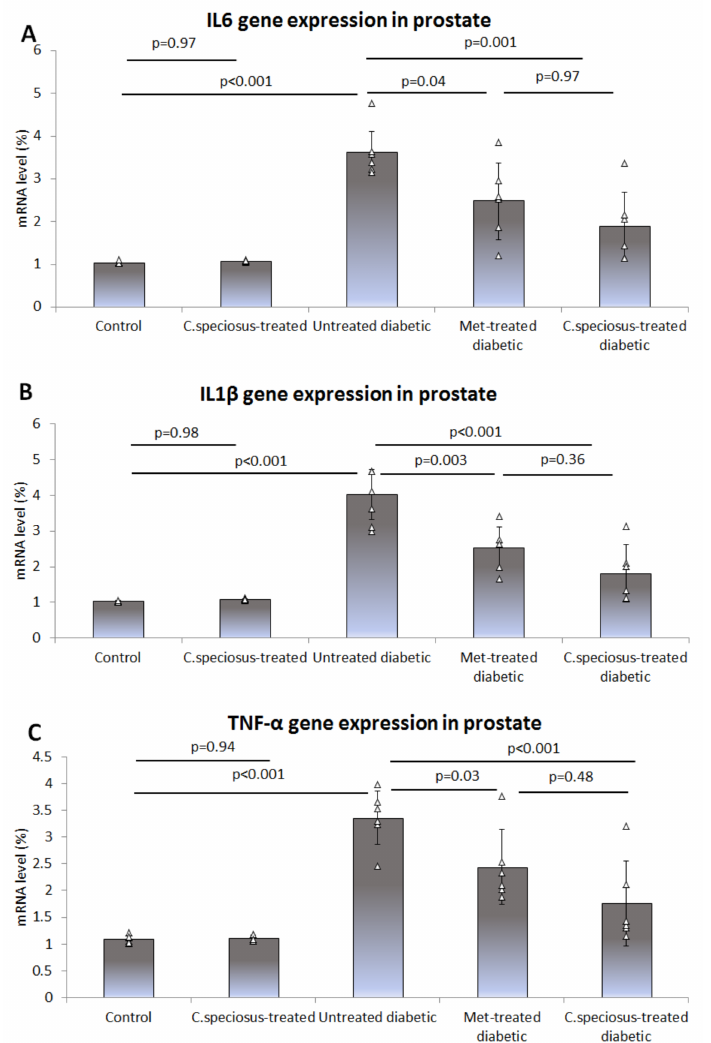
Figure 3. Expression of the mRNA of pro-inflammatory cytokines IL-6 ( A ), IL1 β ( B ) and TNF- α ( C ) in the ventral prostate of the studied groups was estimated using qRT-PCR. Results are presented as mean ± SD, n = 10. The studied groups were compared using one-way ANOVA test followed by the Bonferroni post-hoc test. Significance is considered at p <